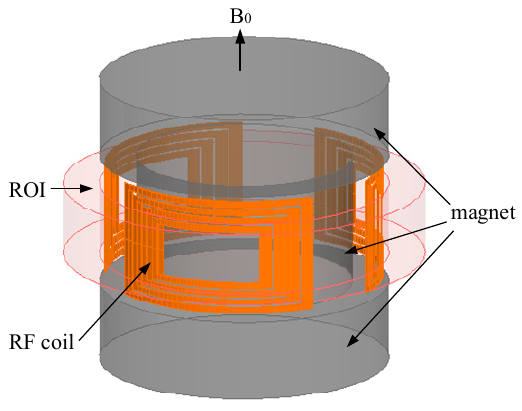
Figure 1. Mini NMR sensor model.